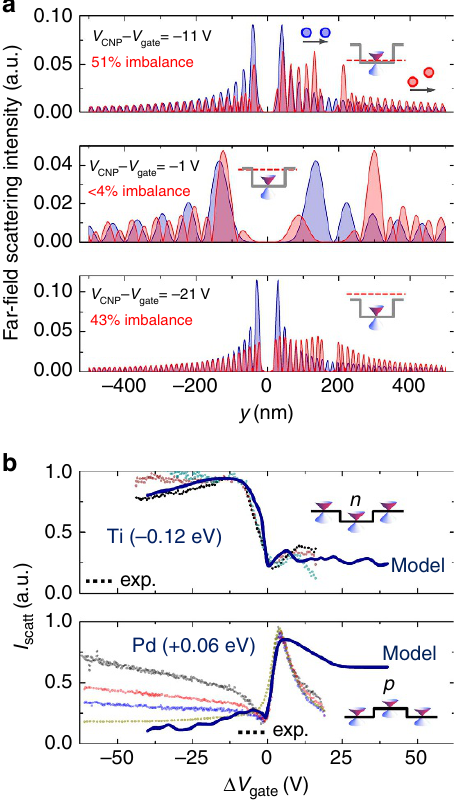
Figure 3 | Modelling cascaded Mie scattering of electronic waves and resulting transverse-signals. ( a ) From top to bottom, the cross-sections of the electronic far-field scattering intensity, 100nm after scattering from two negative-valued circular potentials (100nm diameter, cf . Fig. 1c,d), along the y axis of a 2D-SL unit cell (centre y ¼ 0) for gate-voltages V gate ¼ (cid:2) 11V, (cid:2) 1V and (cid:2) 21V relative to the charge-neutrality point V CNP . Canted potential arrangements ( a 2D (cid:2) SL ¼ 30 (cid:2) ) are in red and aligned ( a 2D (cid:2) SL ¼ 0 (cid:2) ) are in blue. For all canted cases an imbalance of intensity (integration over corresponding axis intercept) relative to the unit-cell centre is found depending on the position of the Fermi-level (gate-voltage). No imbalance is found for any aligned case. The establishment of an imbalance (difference in intensity) is equivalent to a transverse-voltage generation across the unit-cell. The oscillatory behaviour is characteristic for Mie scattering. Insets: Schematic of Fermi-energy position (dashed line) relative to the potential well (grey line); circles and arrows indicate the orientation of the two circular potentials relative to the incident electronic wave (current) direction for a 2D (cid:2) SL ¼ 0 (cid:2) and 30 (cid:2) . ( b ) Total scattered far-field intensity I scatt for a negative-valued (top) and a positive-valued (bottom) single circular potential as a function of D V gate with potential magnitudes as extracted from our experiments using Ti and Pd dots. Dotted lines are scaled experimental transverse-voltage data for a Ti-defined and a Pd-defined 2D-SL sample taken at different biases (range 0.5–6mV, Supplementary Fig. 4, Supplementary Method 2). Our calculations reproduce remarkably well for both types of potentials the minimum and maximum and their positions in all the displayed experimental transverse voltages. Systematic deviations towards higher gate-voltage magnitudes are attributed to higher-order scattering processes not considered in our